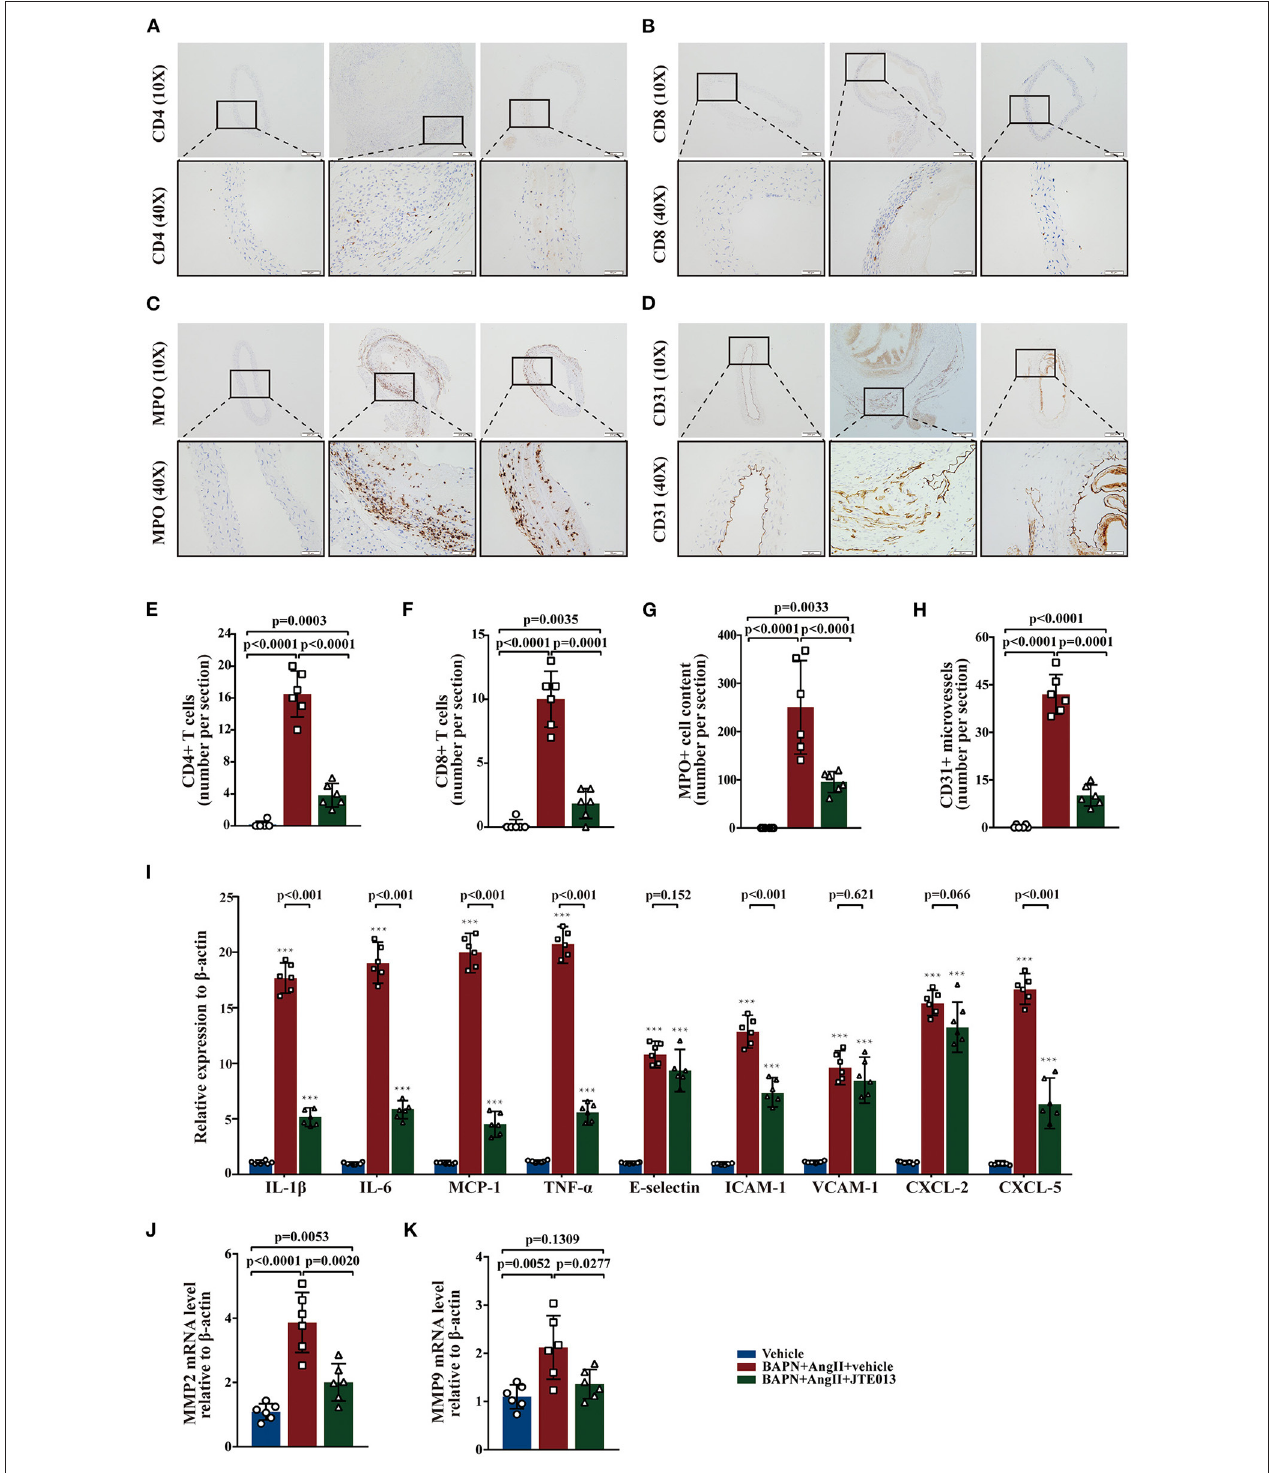
FIGURE 4 | Inhibition of S1PR2 by JTE013 reduced inflammatory infiltration and angiogenesis. (A,E) Lesion CD4 + T-cell numbers and corresponding analysis. (B,F) Lesion CD8 + T-cell numbers and corresponding analysis. (C,G) Lesion MPO + neutrophil numbers and corresponding analysis. (D,H) Lesion CD31 + micro-vessel numbers and corresponding analysis. (I) RT-qPCR determined lesion mRNA levels of IL-1 β , IL-6, MCP-1, TNF- α , E-selectin, ICAM-1, VCAM-1, CXCL-2, and CXCL-5. (J,K) Analysis of MMP2 and MMP9 mRNA expression. n = 6 mice per group. *** p < 0.001 vs. the vehicle group. Scale: 200 µ m, inset: 50 µ m. Data are expressed as means ± SD. Myeloperoxidase (MPO), a marker for neutrophil abundance.